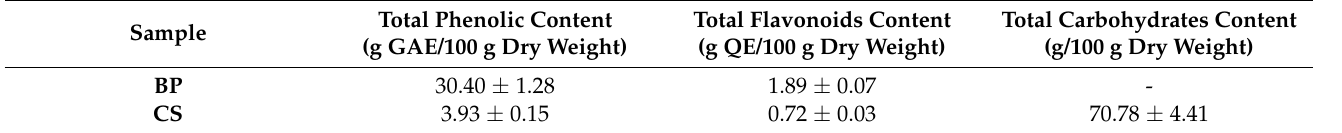
Table 1. Total phenolic, flavonoid and carbohydrate content of blueberry pomace extract (BP) and chia seed extract (CS). The results are expressed as mean ± SD ( n = 3).